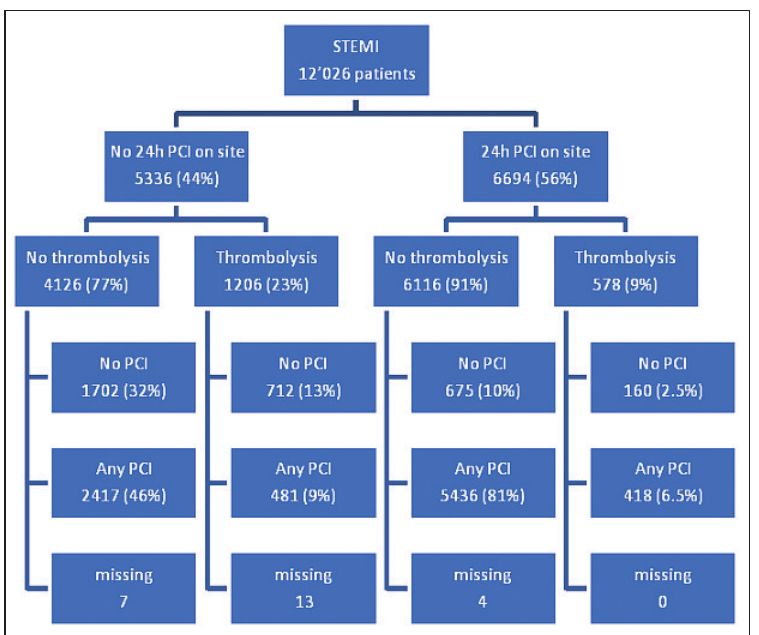
Management of patients.